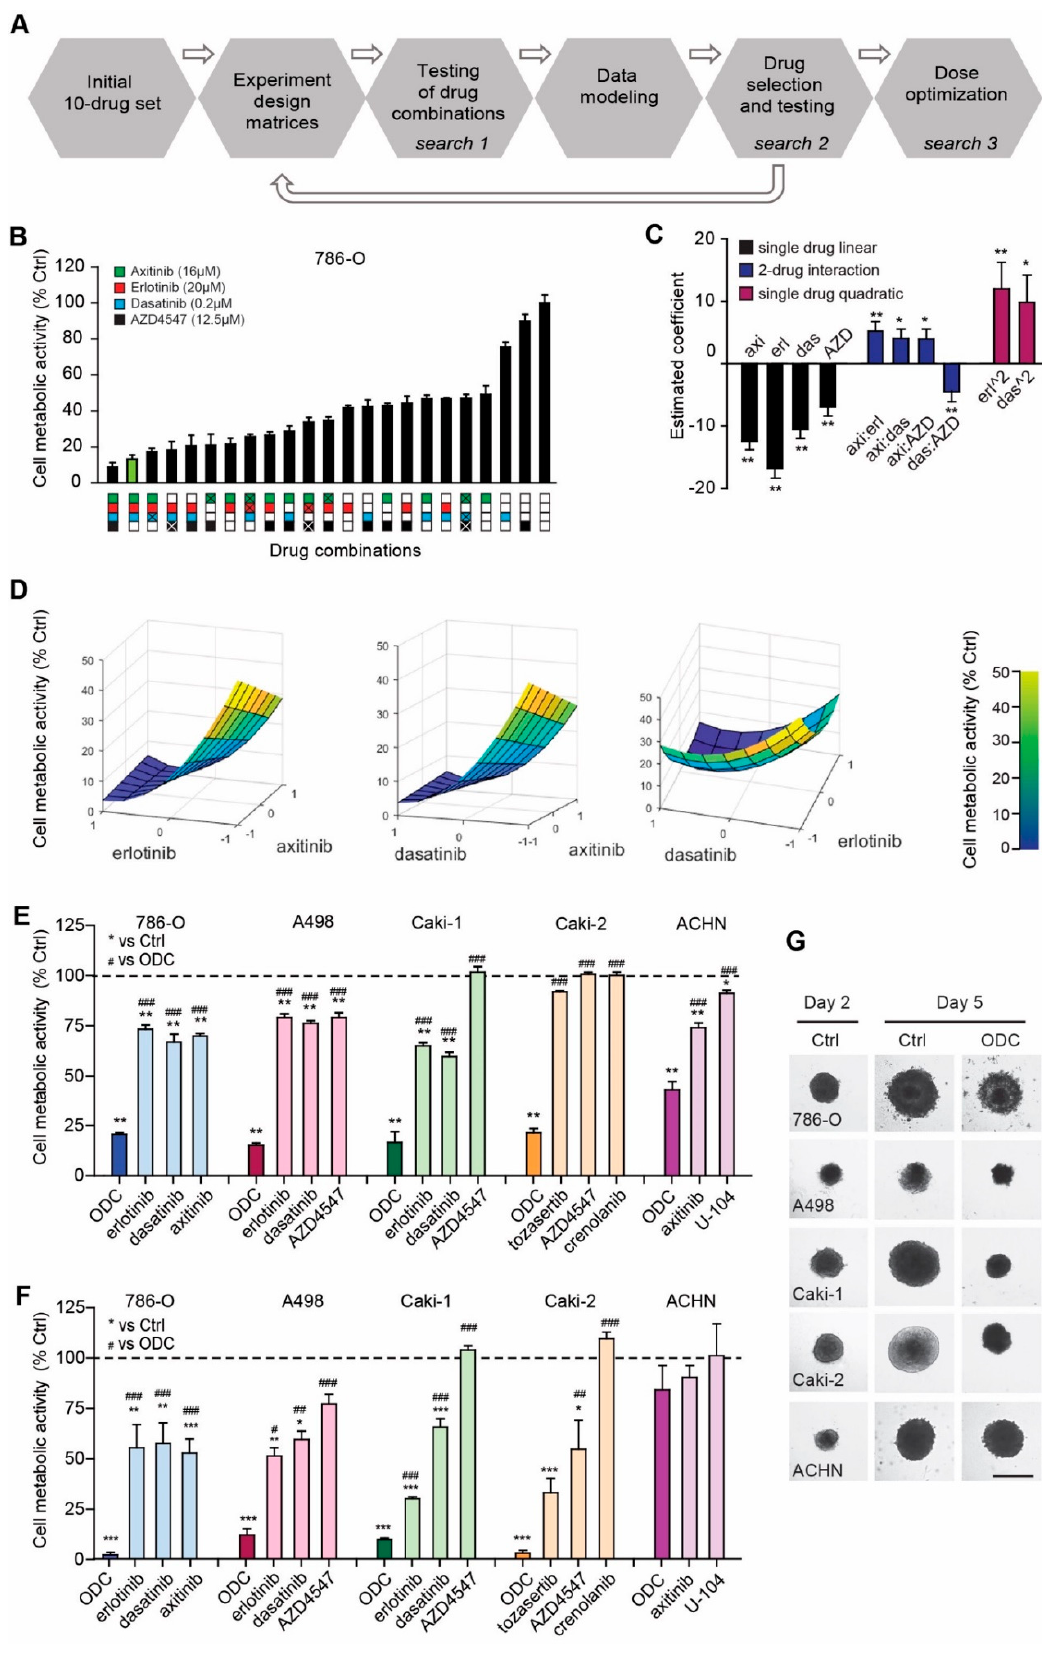
Figure 1. Selection of optimal drug combinations (ODC) using streamlined-feedback system control (s-FSC). ( A ) Schematic of s-FSC. For a selection of 10 drugs, dose–response curves are generated in the cell types of interest. Mathematic modeling and regression analysis of experimental data drive